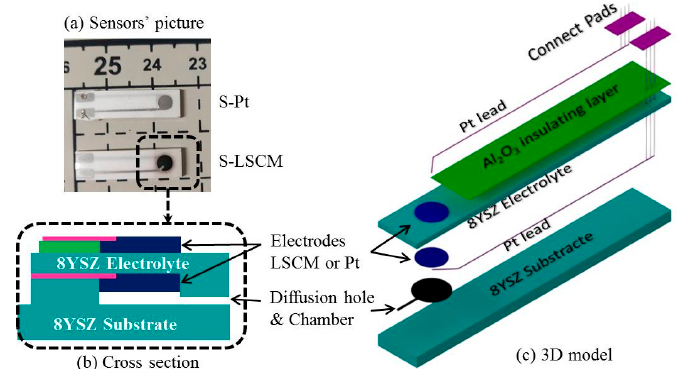
Figure 1. Schematic diagram of limiting current oxygen sensor.